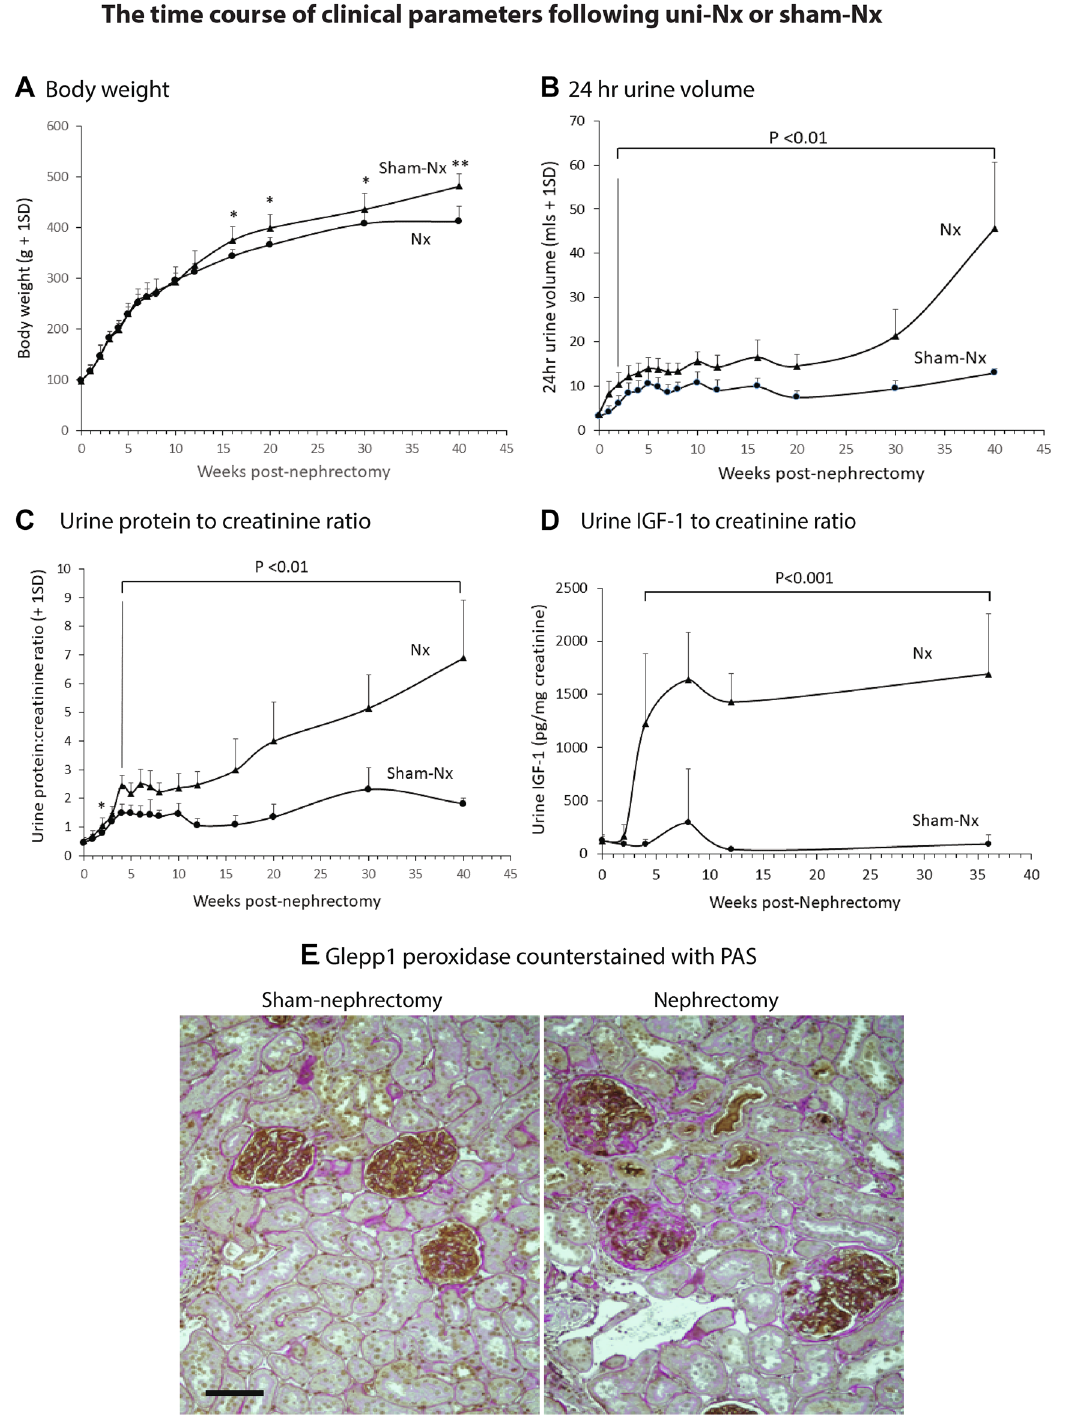
Figure 2. Clinical data for the long-term rat uni-nephrectomy versus sham nephrectomy study. Panel ( A ) Body weight gain. Panel ( B ) 24 h urine volume. Panel ( C ) Urine protein:creatinine ratio. Panel ( D ) Urine IGF-1 to creatinine ratio. Panel ( E ) Histology at 40 weeks post-nephrectomy or sham-nephrectomy. Glepp1 peroxidase (brown) is used to identify podocytes in sections counter-stained with Periodic Acid Schiff (PAS) reagent. Note larger glomeruli in nephrectomized rats together with loss of podocytes (brown) and increased glomerulosclerosis (pink) in glomeruli of uni-nephrectomized rats but not in glomeruli of sham- nephrectomized rats. While 50% of glomeruli had some level of sclerosis only 2.8% of glomeruli were globally sclerotic. Interstitial scarring in the uni-Nx rats is shown by pink staining. The bar represents 50um. * P < 0.05, ** P <